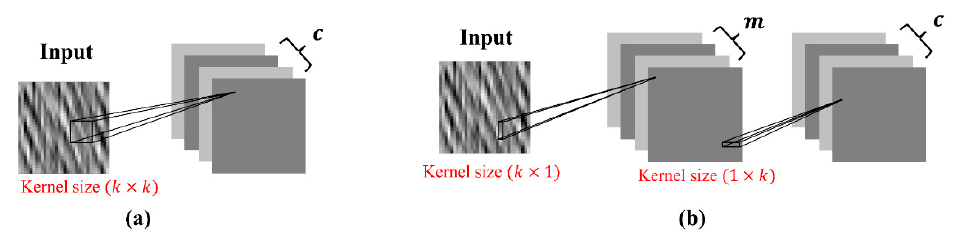
Figure 3. Schematic of ( a ) conventional convolution and ( b ) vector-based convolution.